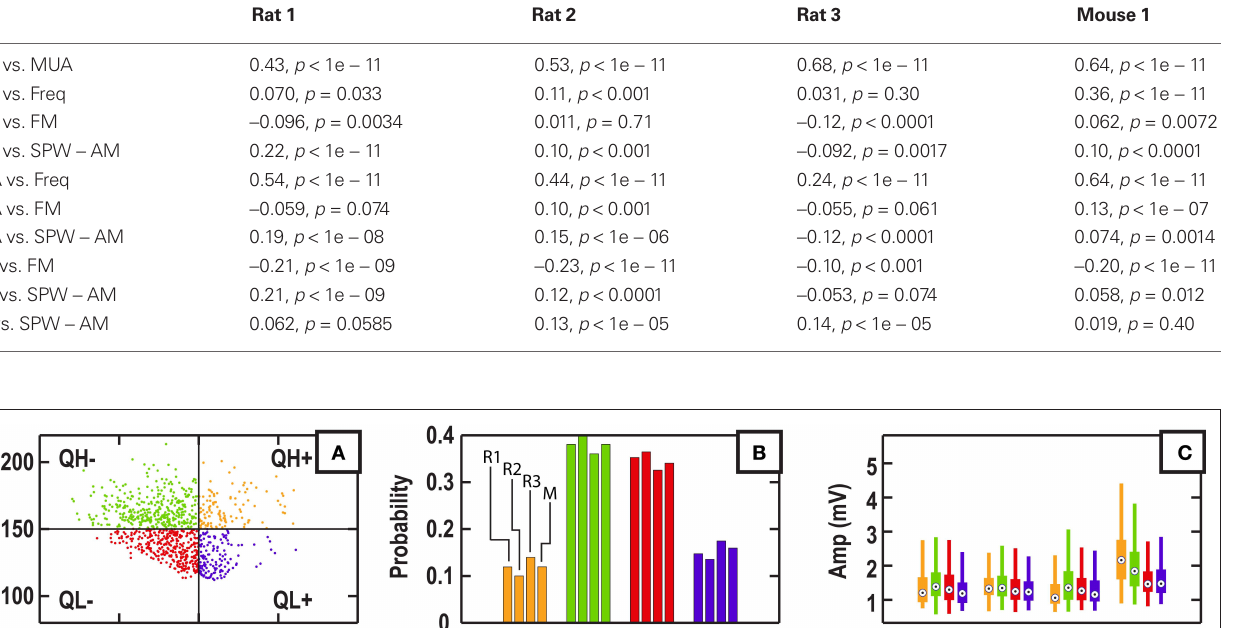
Table 1 | Correlation coeffi cients ( R ) and p -values which measure the relationship between ripple features combinations. We defi ne signifi cant correlations to be correlations that have a statistical power of p < 0.001 for at least three out of four subjects.